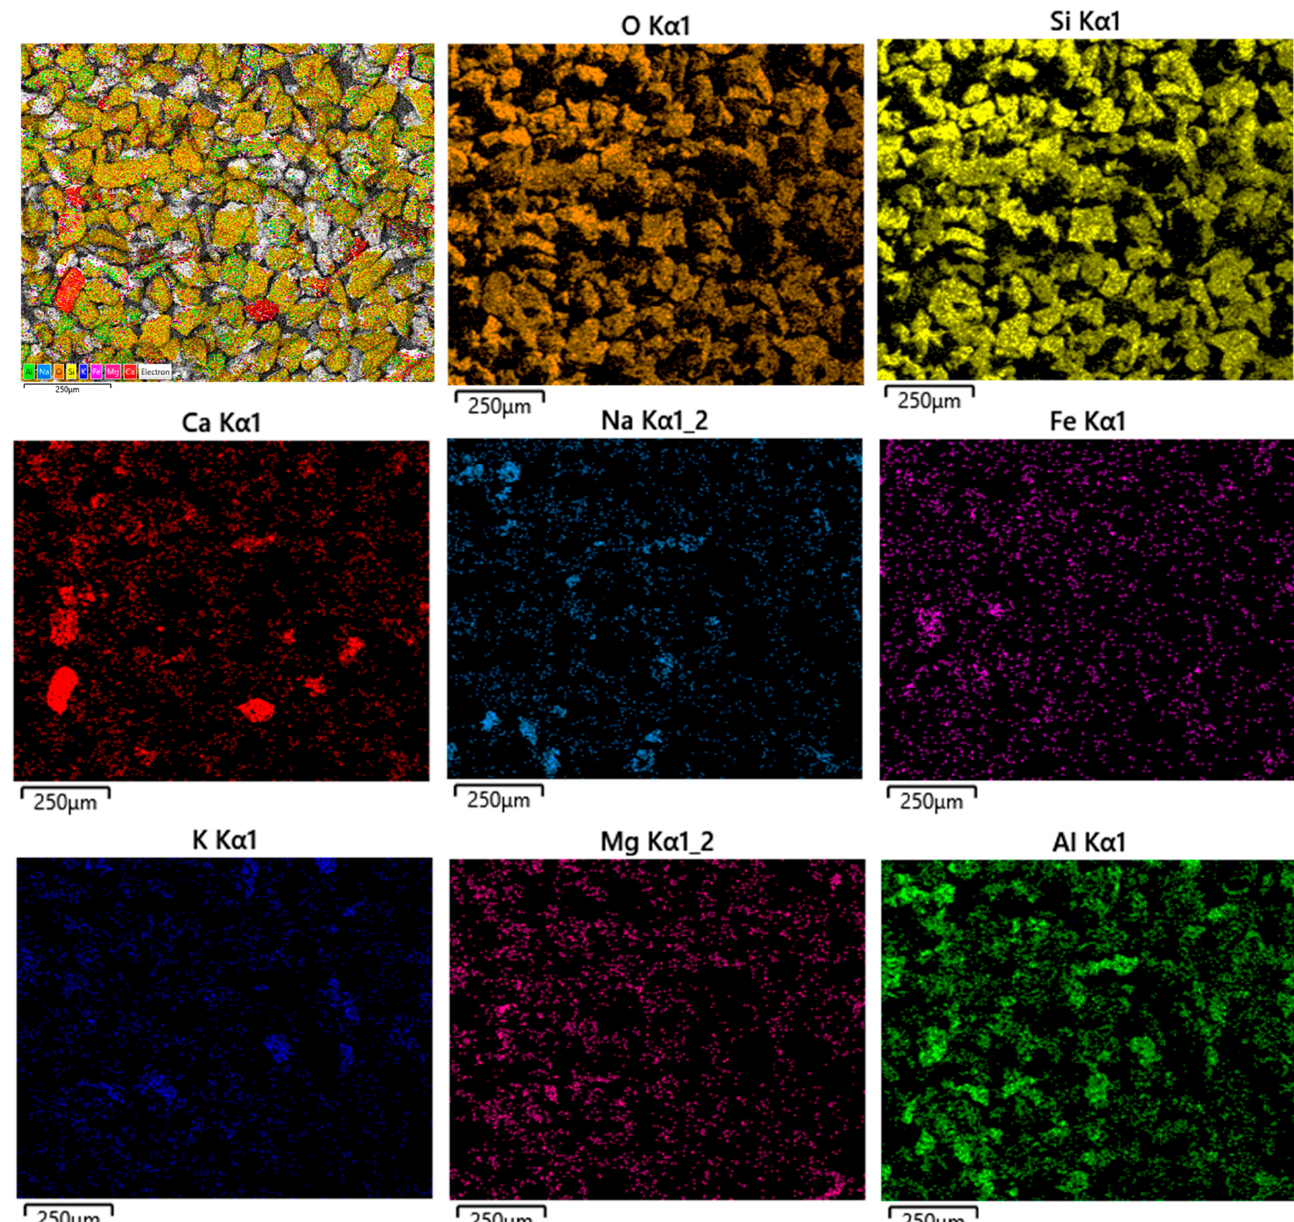
Figure 3. Elemental distribution maps for the quartz particle size ranging from 40 to 50 µm.